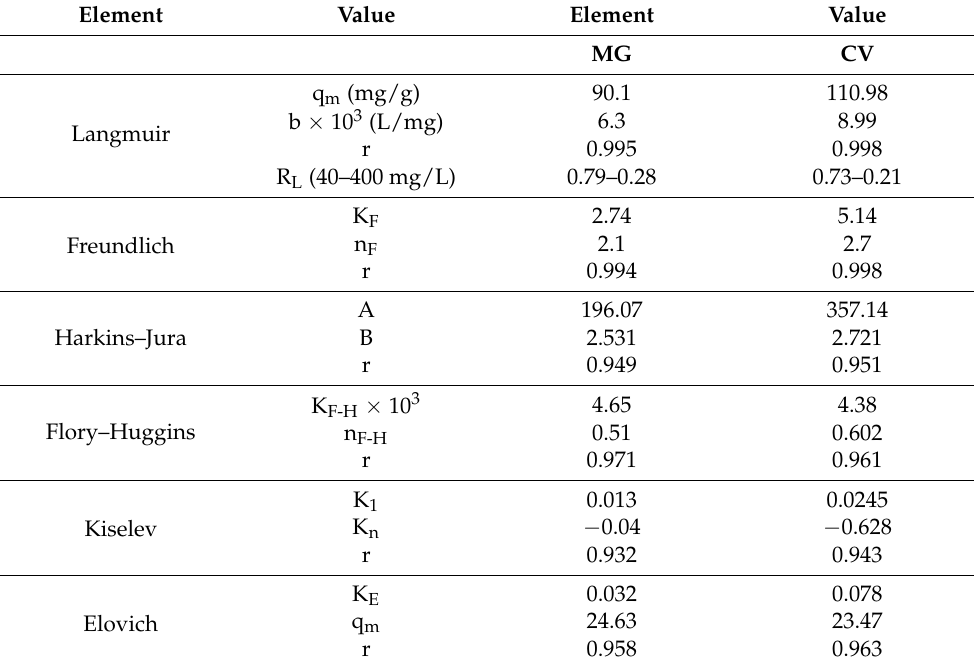
Table 7. Parameters of isotherm models for MG and CV biosorption on ALP at 298